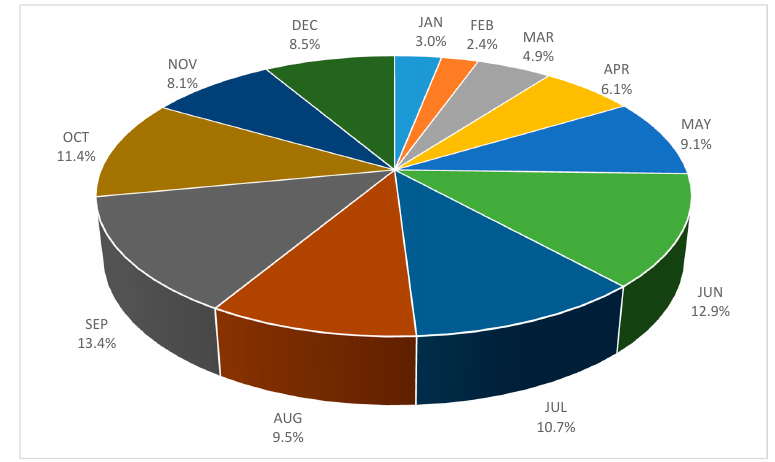
Figure 4. Shares of conference papers published in the individual months of the year.